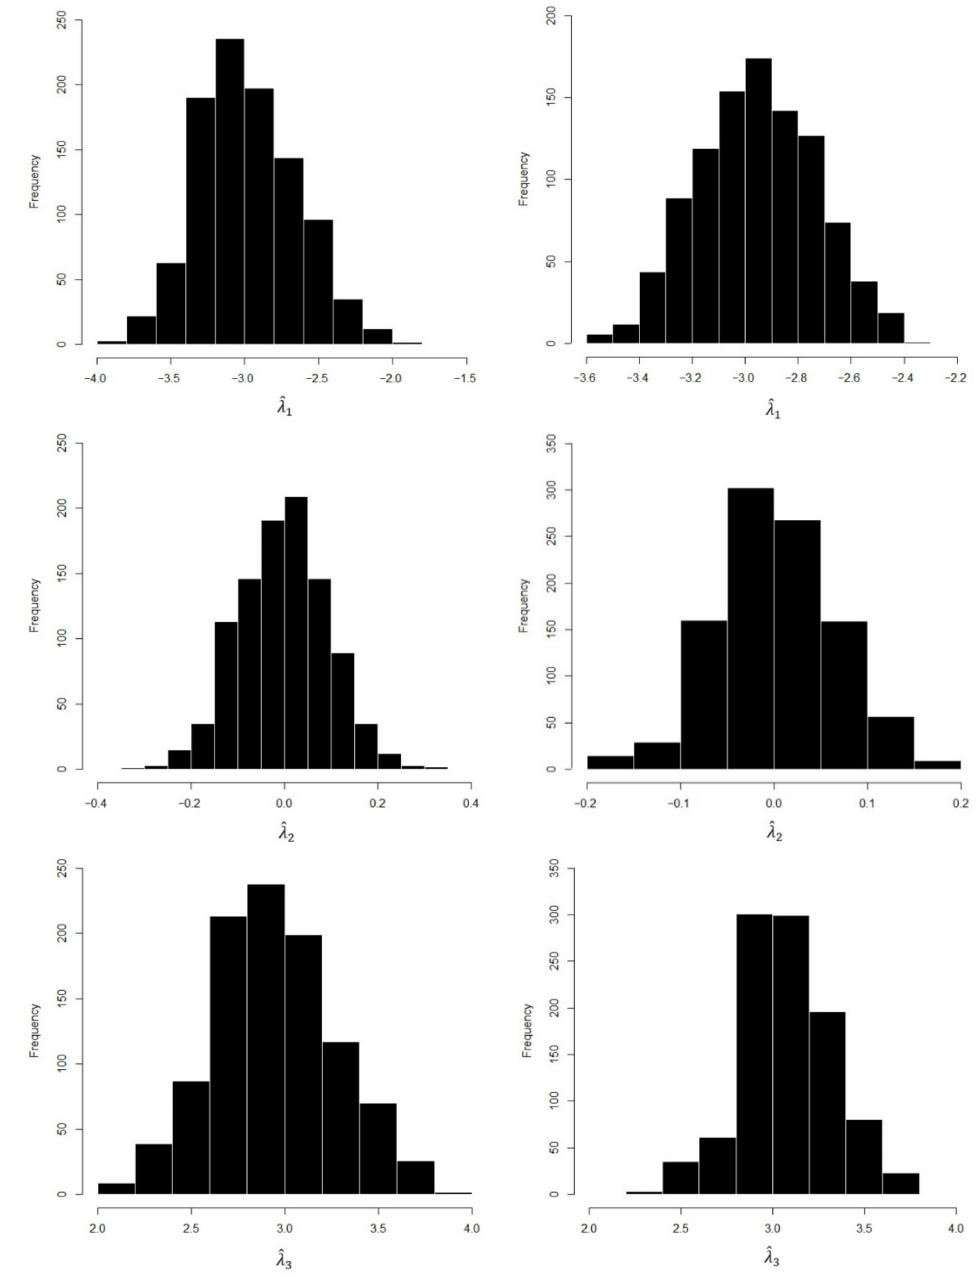
= 0.5 2 and σ 2 = 0.4 2 . The left 1